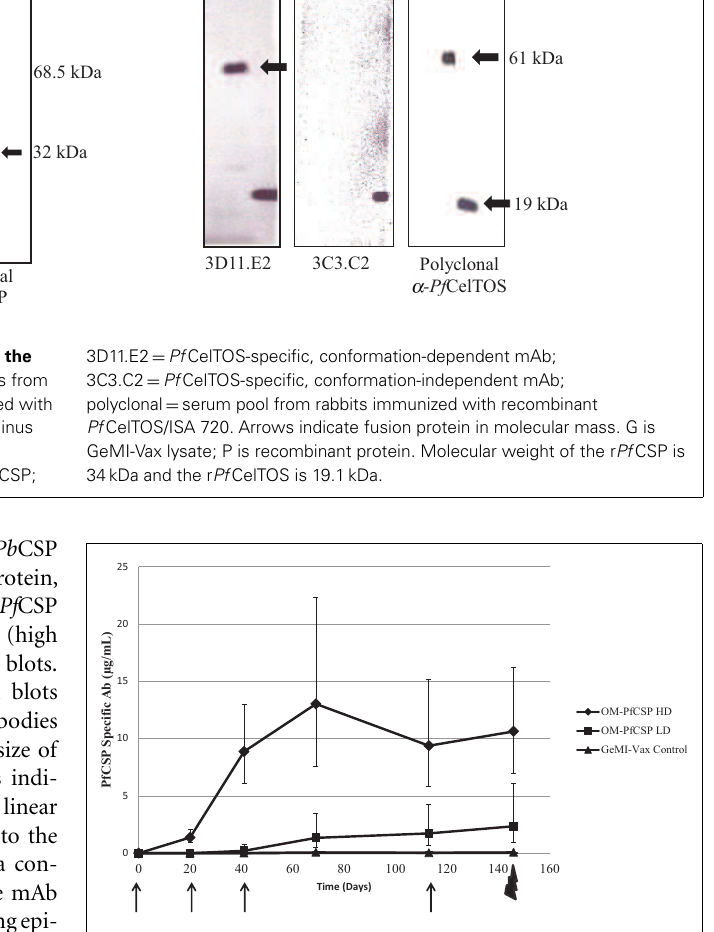
FIGURE 8 | Kinetics of the humoral immune responses induced by Shigella GeMI-Vax . Sera from mice immunized with OM- Pf CSP HD (high dose) and OM- Pf CSP LD (low dose) were collected prior to, 3weeks after each immunization and 1day prior to the challenge and were analyzed using a quantitative ELISA. Data are expressed as the geometric mean Pf CSP-specific antibody concentration ( µ g/mL) and the error bars represent the 95% confidence interval of n = 10 mice/group. Arrows indicate the days of immunizations, Day-1, 20, 41, and 113, and the bolt indicates time of challenge. Mice were immunized with either high dose = 1.7 × 10 9 cells or low dose = 1.7 × 10 7 number of cells. At each time point following the primary immunization, Pf CSP-specific antibody responses for the OM- Pf CSP HD group were significantly higher than for the OM- Pf CSP LD group (ANOVA, p <